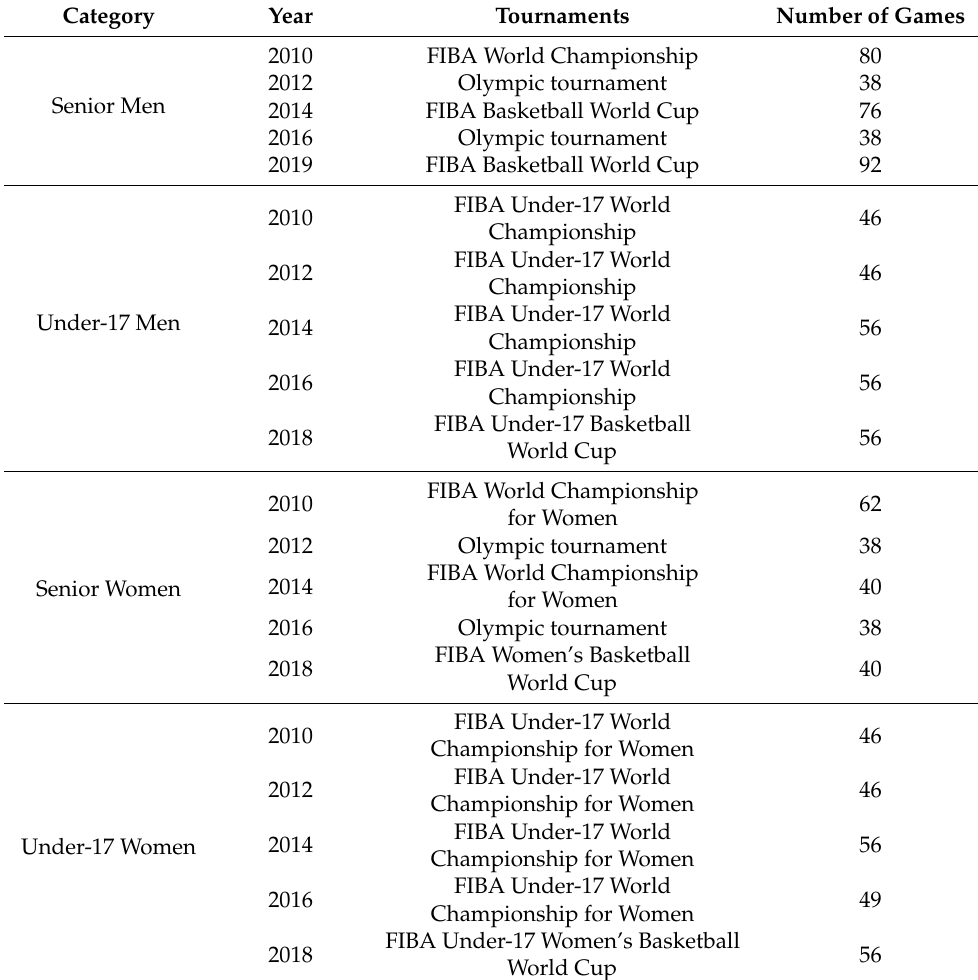
Table 1. Tournaments analyzed in this study.